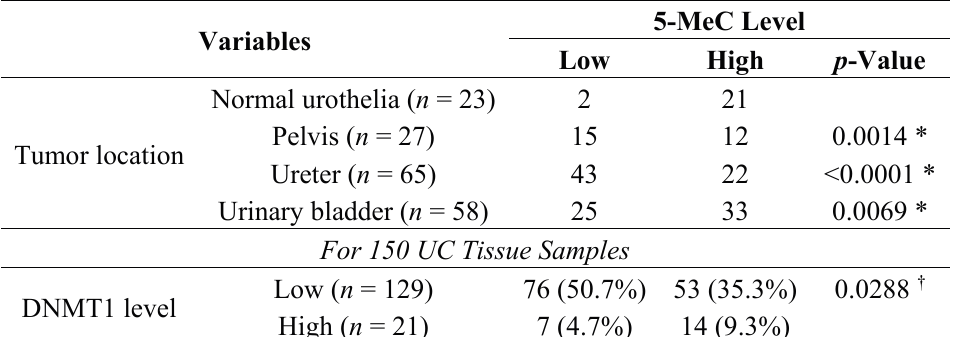
5-MeC, 5-methylocytosine; DNMT1, DNA (cytosine-5)-methyltransferase 1. Percentage in bracket